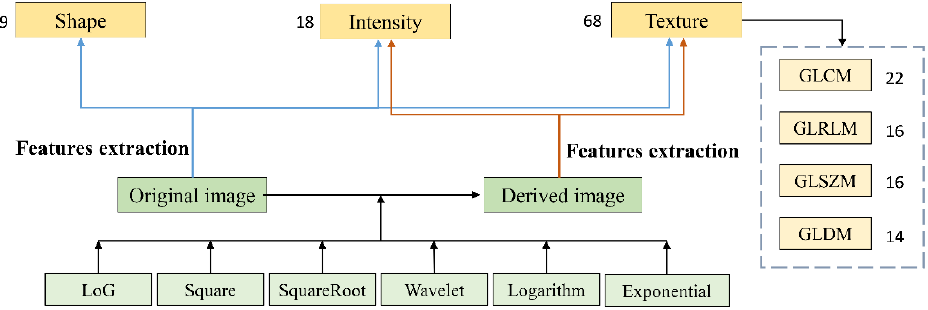
Figure 3. Type and number of extracted radiomics features.